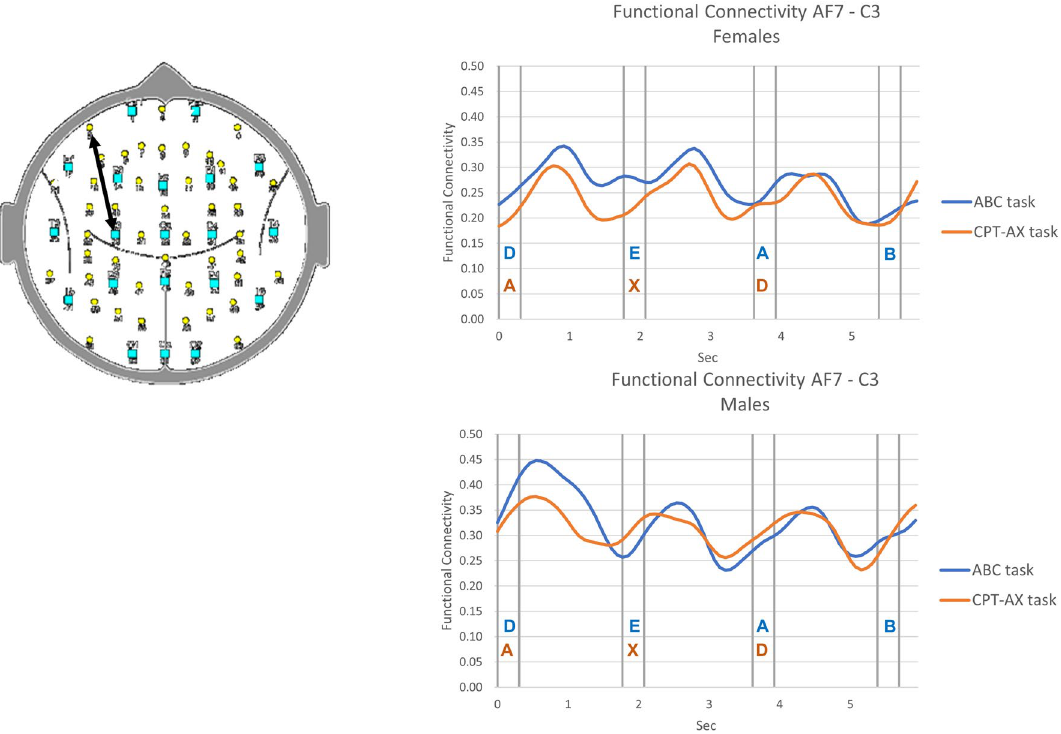
Figure 1. Example of functional connectivity (FC) between left frontal sites (AF7 – C3) during performance of the ABC task (blue trace) and CPT-AX task (red trace). Presentation of the vigilance task stimuli were associated with variations in FC. The horizontal line represents the average value of FC over the 6 s